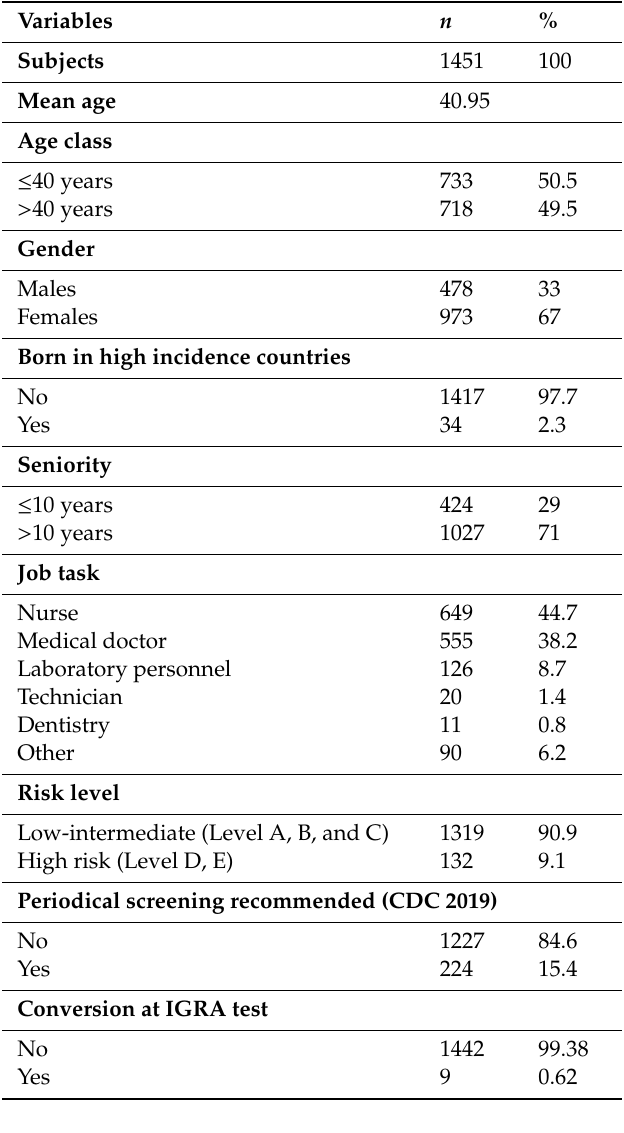
Table 1. Main characteristics of study population. IGRA: Interferon-Gamma Release